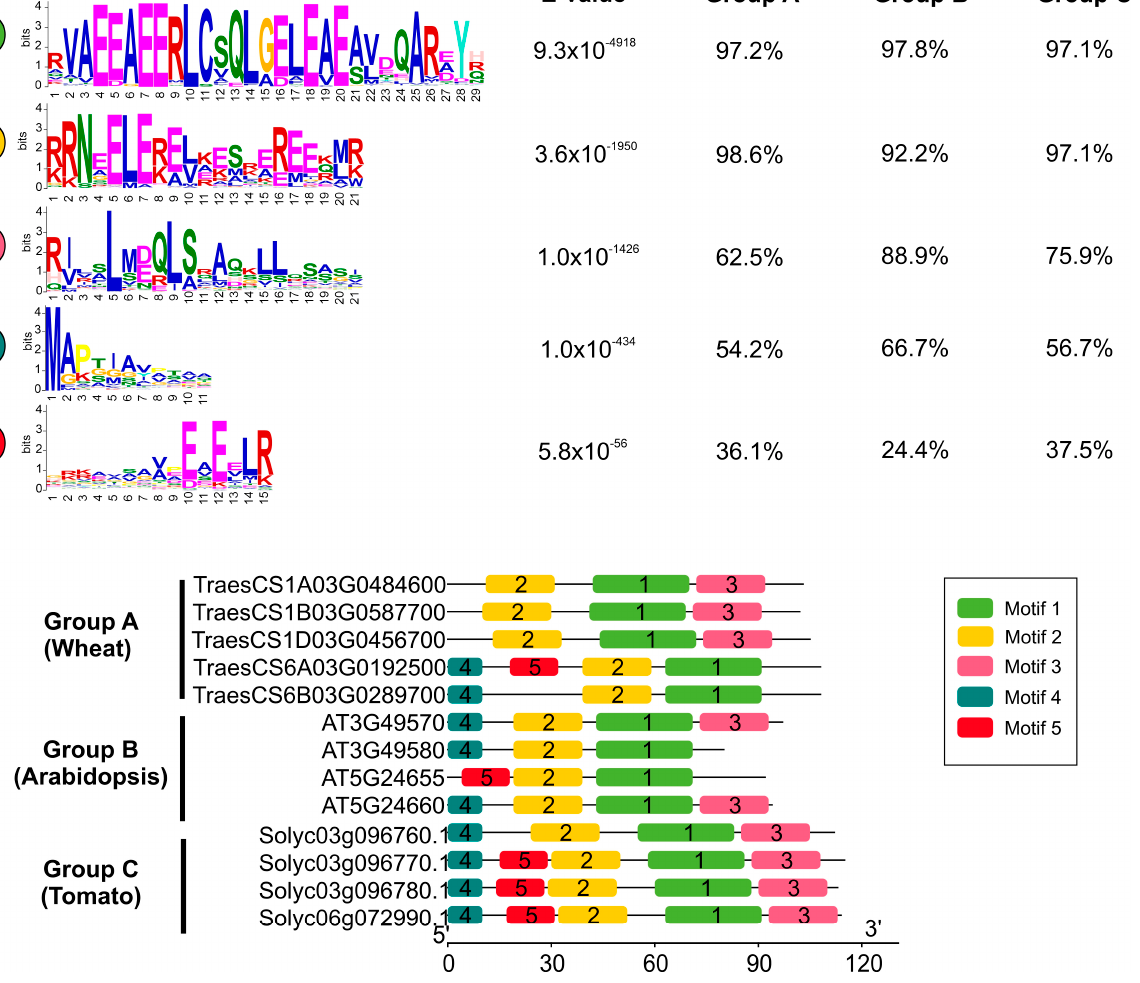
Figure 4. Conserved motif composition of the LSU gene family. ( A ) The conserved motifs were identified using the MEME tool [40], and the % distribution across the three phylogenetic groups is indicated right to the motif. ( B ) Five putative motifs are indicated by colored boxes in representative species of each phylogenetic group.